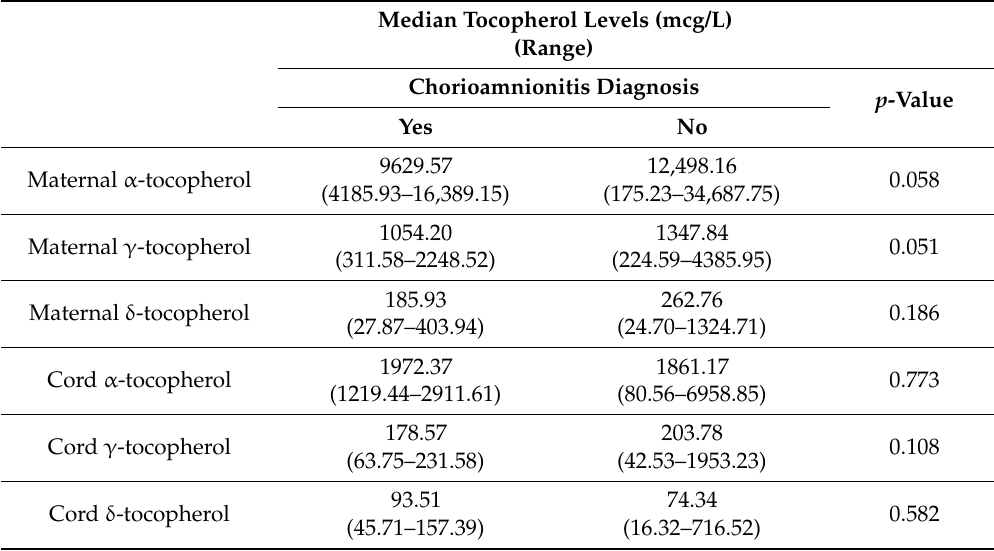
Table 4. United States maternal and cord plasma tocopherol levels by diagnosis of chorioamnionitis *. Median Tocopherol Levels (mcg/L) (Range) Chorioamnionitis